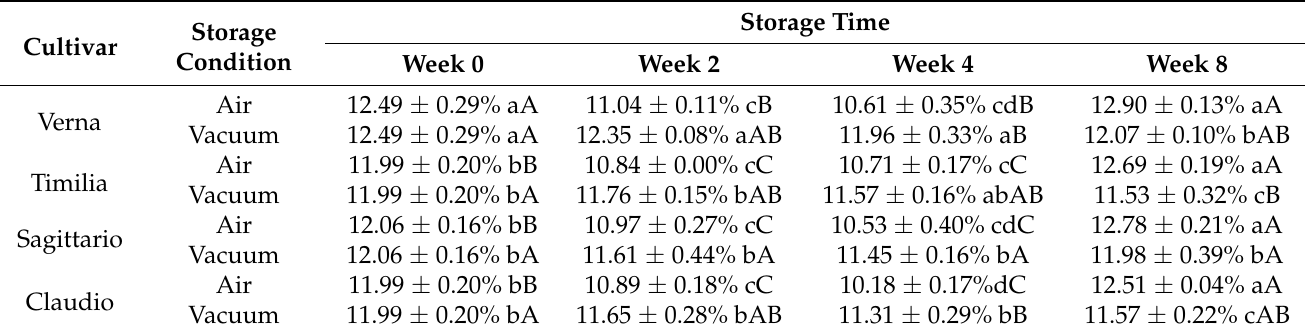
Table 1. The moisture content of four wheat genotypes stored under different conditions and for different lengths of time.